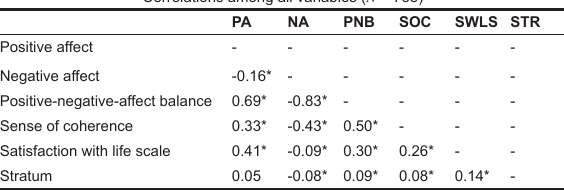
TABLE 2 Correlations among all variables ( N = 738)